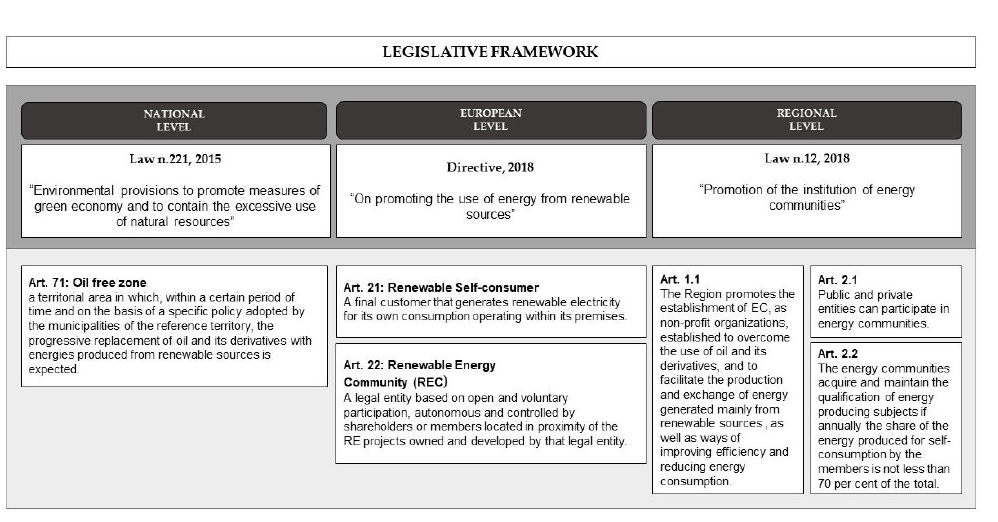
Figure 1. The legislative framework of energy communities.